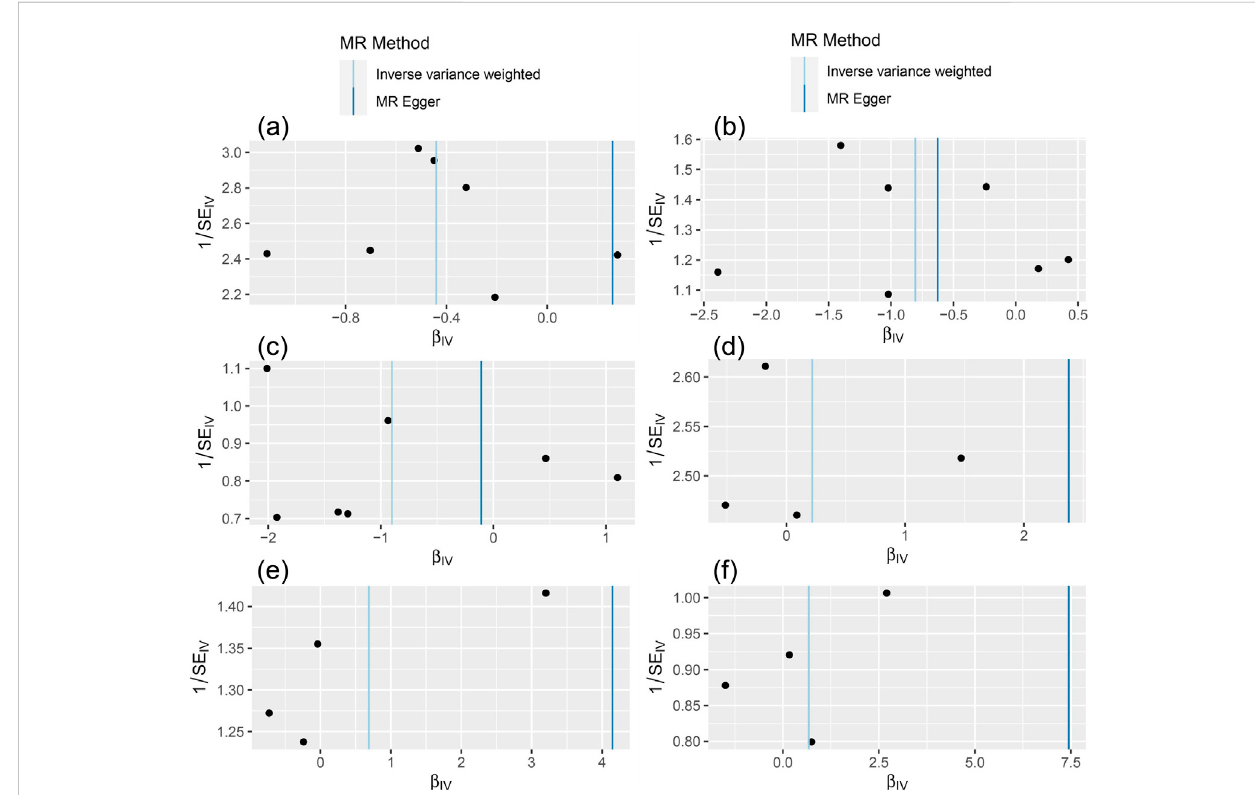
Theresults offunnelplot[The (A – C) represent thecausalin fl uence oflightPA onCOVID-19susceptibility,hospitalization,andseverity respectively, the (D – F) represent the causal in fl uence of moderate-to-vigorous PA on COVID-19 susceptibility, hospitalization, and severity